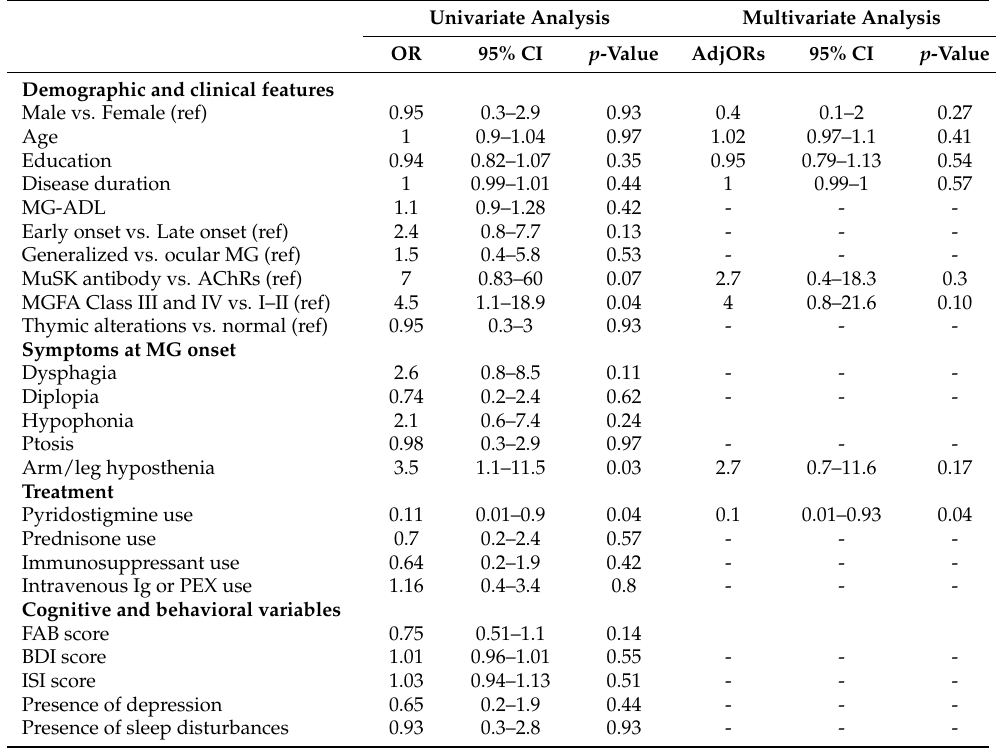
Table 2. Univariate and Multivariate analysis exploring clinical, immunological, and cogni- tive/behavioral factors associated with MCI in MG patients.